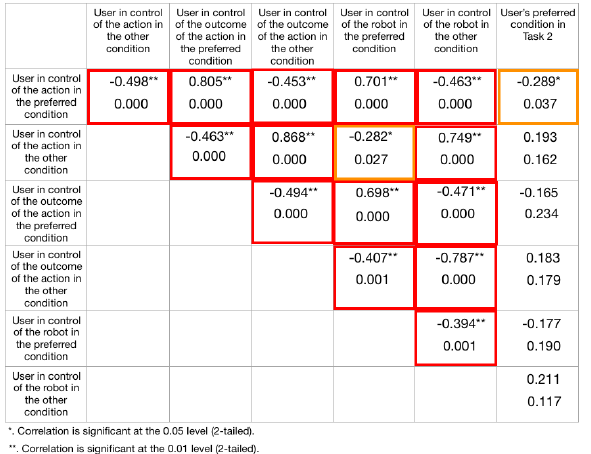
Figure 13: Correlation table for Task 2 "Doctor" between the par- ticipant’s preferred condition and the participant’s perception of control for their preferred condition and their non-preferred condi- tion.